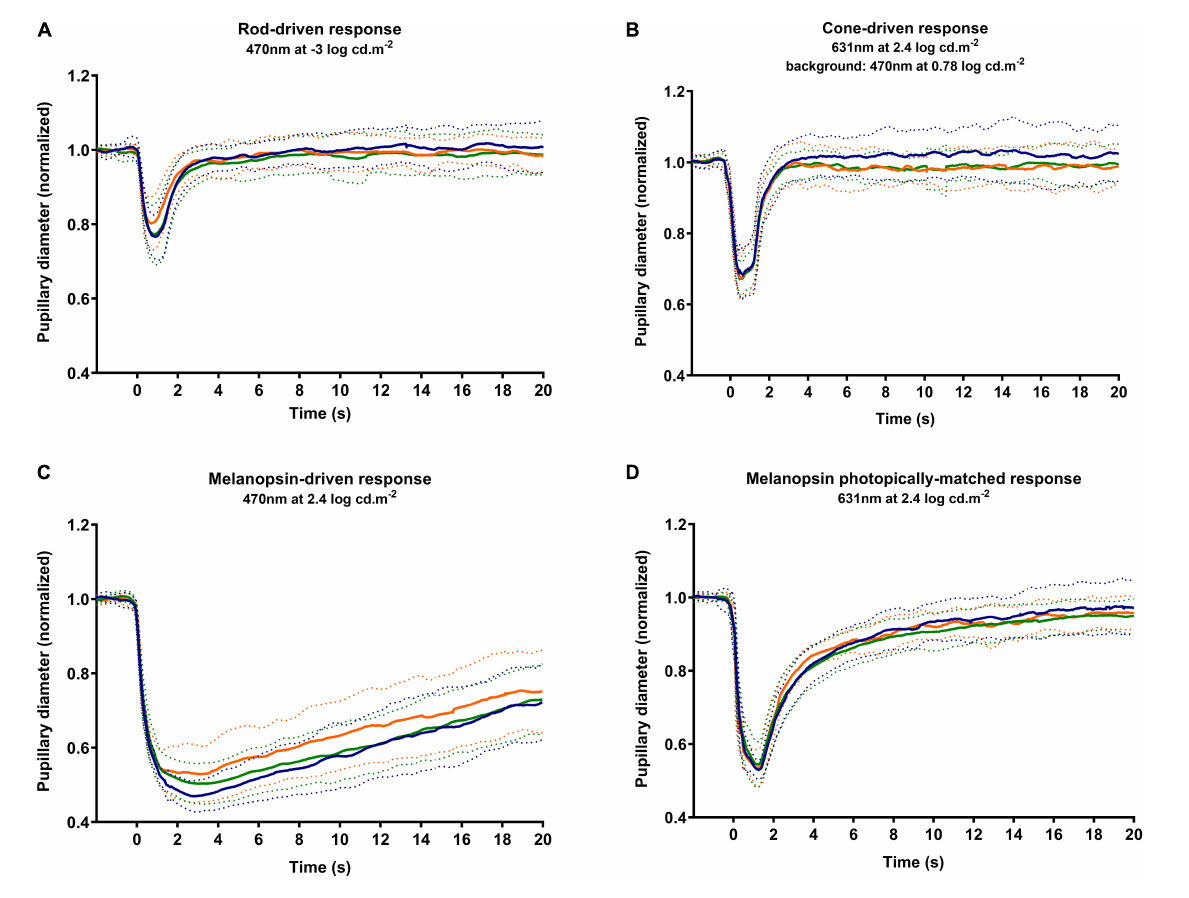
FIGURE3 Average PLRs for each group. The average response is marked as a solid line, and the standard deviation is marked as dotted lines. The responses obtained by the tested stimuli in control (blue markers), early dry age-related macular degeneration (AMD) (green markers), and NVAMD (orange markers) groups were the rod-driven response (A) , cone-driven response (B) , melanopsin-driven response (C) , and a melanopsin photopically matched stimulus (D) . PLR, pupil light reflex; NVAMD, neovascular age-related macular